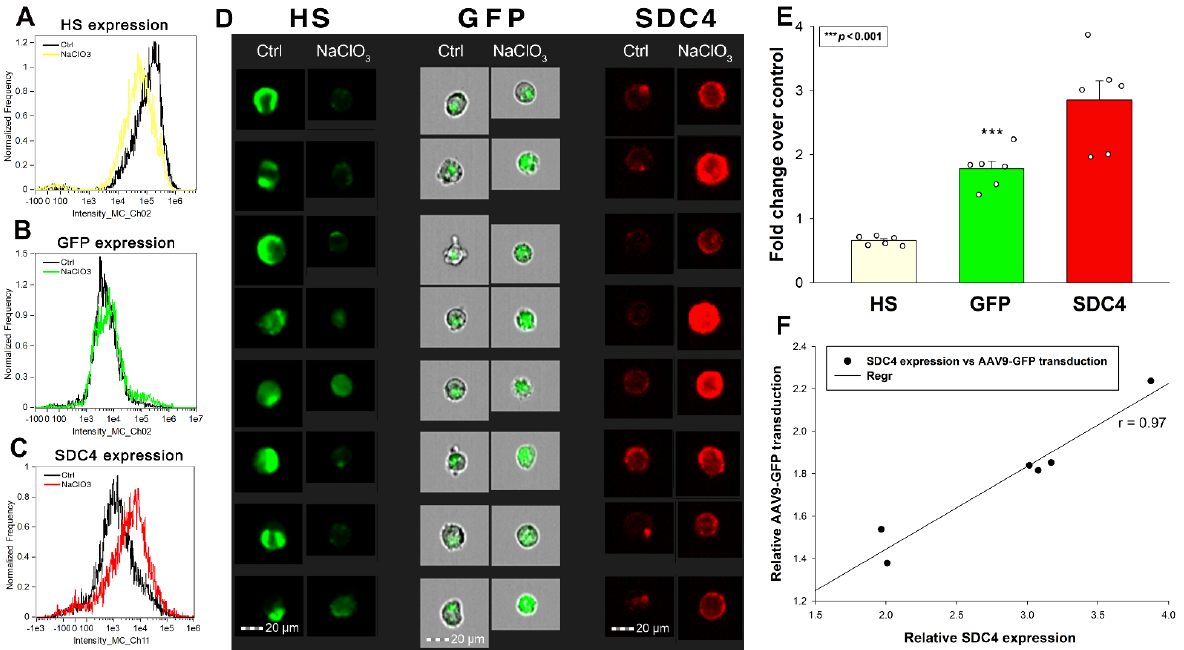
Figure 5. The effect of undersulfation on SDC4 expression and AAV9-mediated gene transduction. Stable SDC4 transfectants (created in K562 cells) were preincubated with or without NaClO 3 for 48 h. Effect of NaClO 3 preincubation on HS and SDC4 expression was measured with imaging flow cytometry by incubating the cells with HS- and SDC4-specific antibodies. SDC4 transfectants prein- cubated with or without NaClO 3 were then treated with AAV9-GFP vectors at 4 × 10 4 vg/cell. After 72 h of incubation with AAV9-GFP, GFP expression was measured with imaging flow cytometry. ( A – D ) Representative flow cytometry histograms and fluorescent cellular images showing HS, GFP, and SDC4 expression of cells preincubated with or without NaClO 3 . Scale bar = 20 μm. ( E ) Detected HS, GFP, and SDC4 expression levels in SDC4 transfectants were normalized to those untreated with NaClO 3 (controls). The bars represent the mean + SEM of six independent experiments. Statis- tical significance was assessed with ANOVA. *** p < 0.001. ( F ) Linear regression between SDC4 ex- pression and AAV9-mediated GFP transduction.